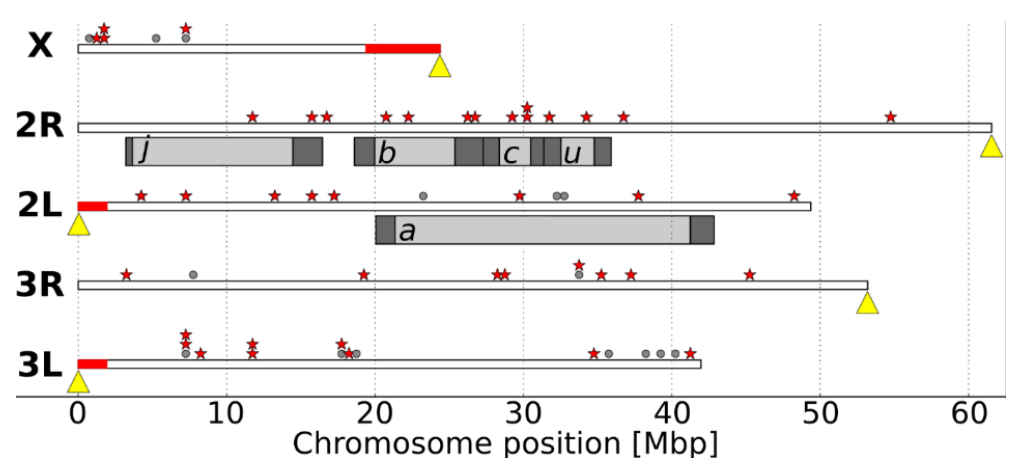
Figure 1. Genome locations of immune genes selected for SNP genotyping depicted by chromosome. Centromere location is marked with a yellow triangle. Red bars indicate the known “speciation islands” of A. gambiae . Red stars mark locations of genes that are significantly diverged. Gray circles mark locations of genes that are not significantly differentiated. Gray bars indicate the location of paracentric chromosome inversions, regions containing inversion breakpoints in dark gray.